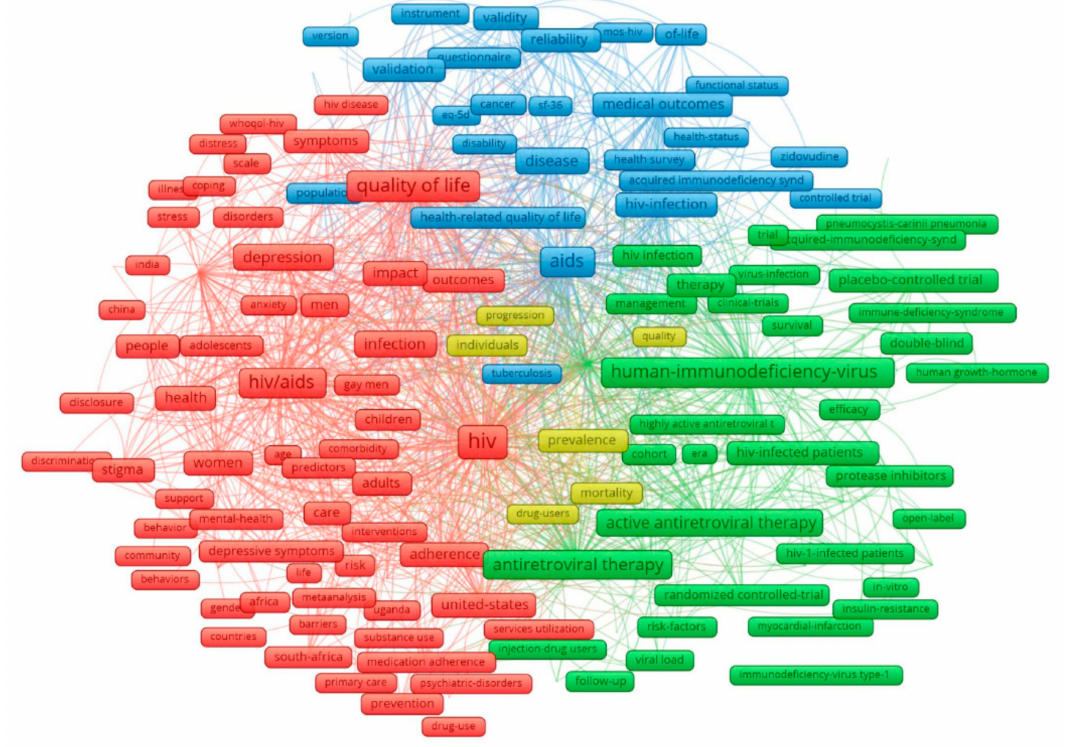
Figure 2. The most common author keywords. Note: the principal components of the data structure were visualized regarding the colors of the nodes; the node size was identified by the keywords’ occurrences; the closer the nodes are, the stronger the association between two keywords are. Cluster 1 (red) covers mental health, social, and associated factors. It includes psychological disorders (depression, anxiety, stress); social behavior (stigma, discrimination); specific HIV groups (such as gay, children, women, and men), and regions (India, South Africa, Uganda). Cluster 2 (blue) presents physical health-related aspects: treatment, outcome, mortality, and disability. Cluster 3 (green) indicates ART adherence studies: study design and laboratory